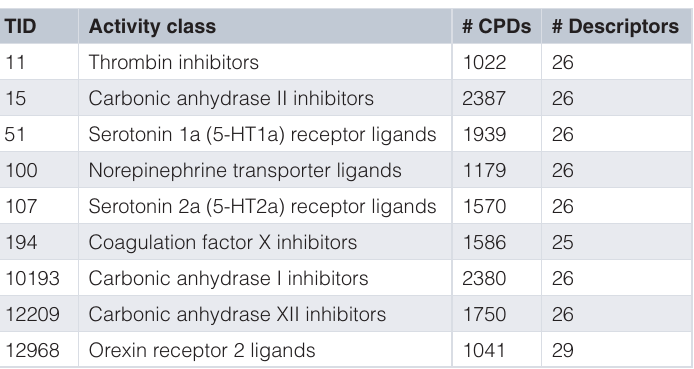
Table 1. Compound data sets. Nine compound activity classes were taken from ChEMBL (version 22). For each activity class, the target ID (TID), number of compounds (CPDs) for which descriptor values were obtained, and number of descriptors following variable selection are